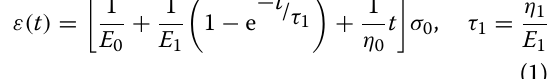
where J 0 and J 1 are instantaneous and delayed elastic compliance, respectively.